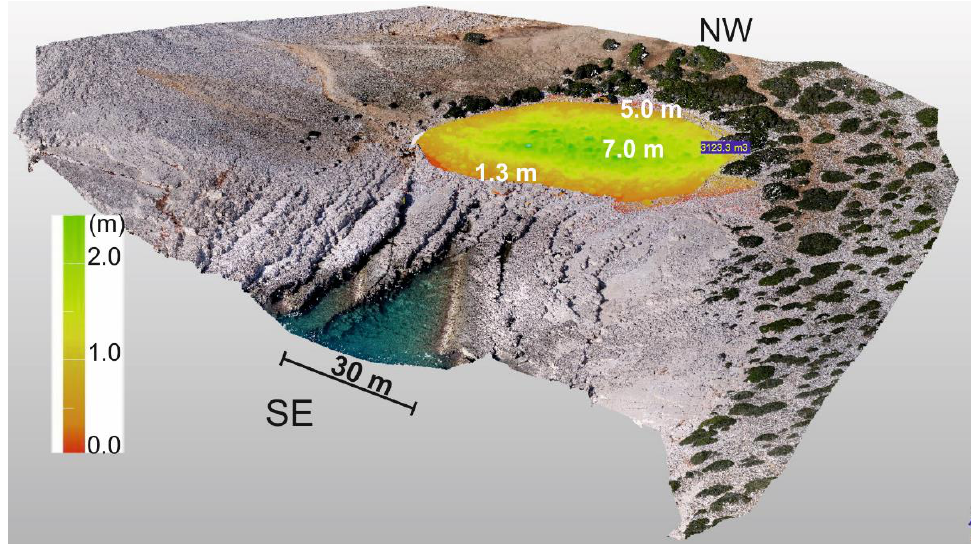
Figure 4. Panorama image (westward view) based on a photogrammetric UAS 3D model of the Mana coarse-clast deposit (see Supplement S1). Color scale (legend) for the modeled thickness of the deposit (thin marginal parts not shown). Elevations above the mean sea level are marked in white numbers.